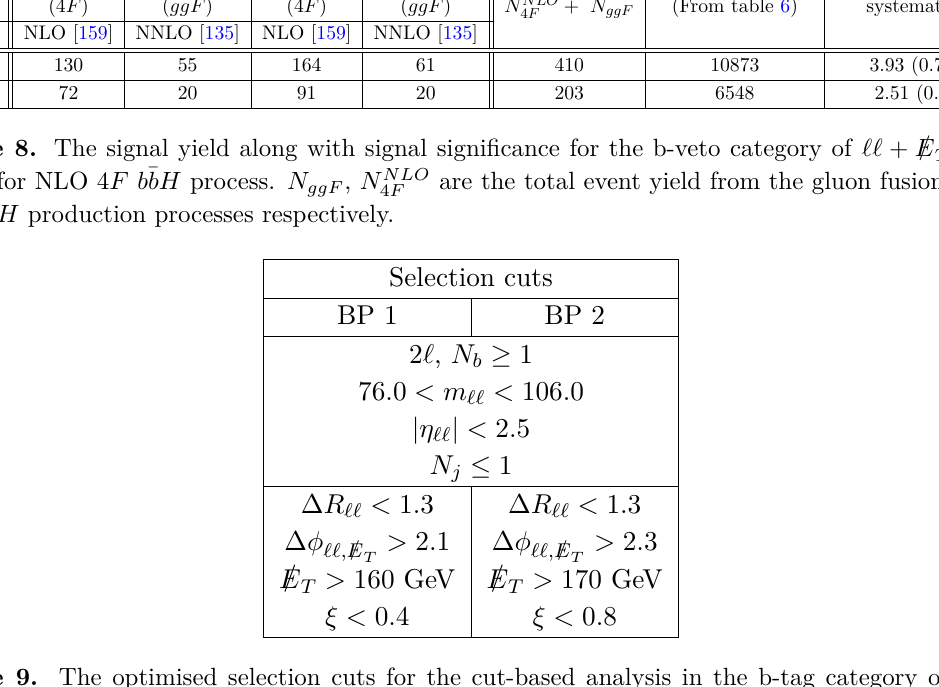
Table 9. The optimised selection cuts for the cut-based analysis in the b-tag category of ‘‘ + /E channel. T